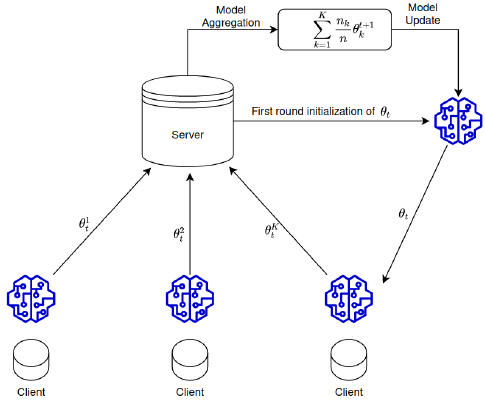
Figure 2. Simplified FL model